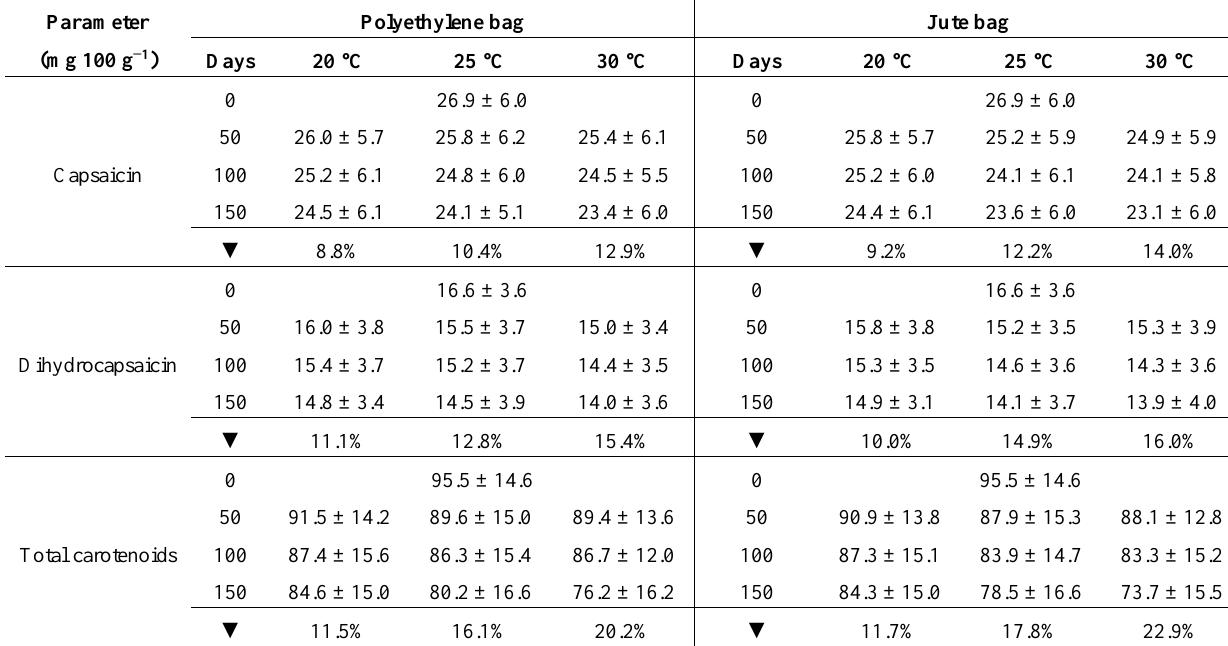
Table 2. Evolution of capsaicinoids and antioxidants in hot peppers under different storage conditions. Data shown are the mean values ± standard deviation for three hot pepper hybrids (Sky Red, Maha and Wonder King), and ▼ is the percent reduction from 0 to 150 days on a dry weight